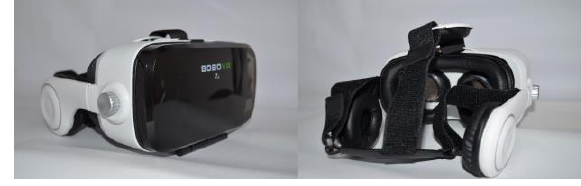
Figure 3. BoboVR Z4.